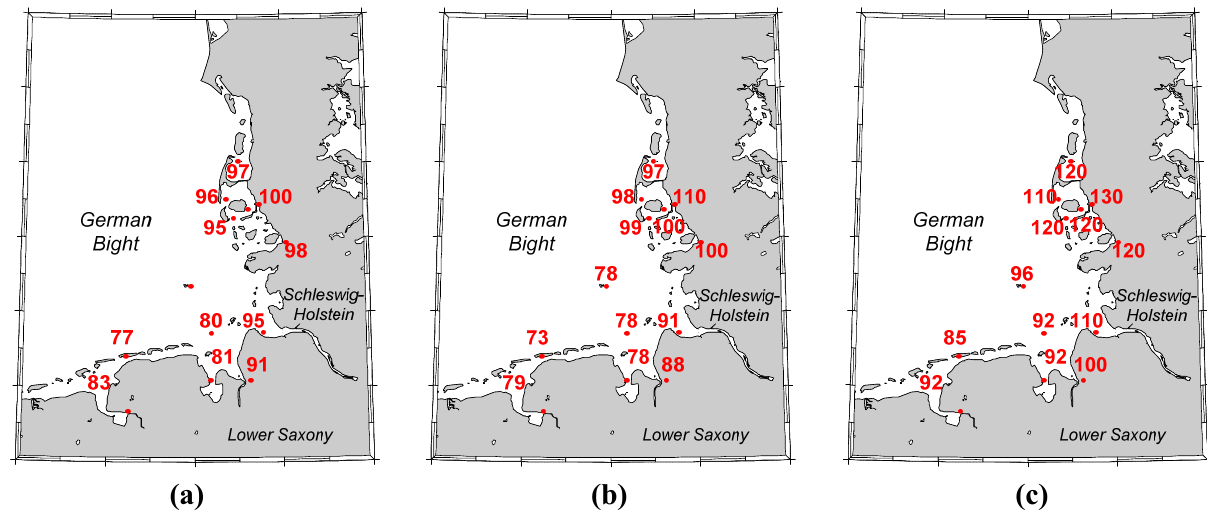
Figure 7. Sensitivity (sea level changes in mm/unit NAO change) of swMSL (January to March) to swNAO for different time spans (1937–2008 ( a ); 1951–2008 ( b ); 1971–2008 ( c )) and different tide